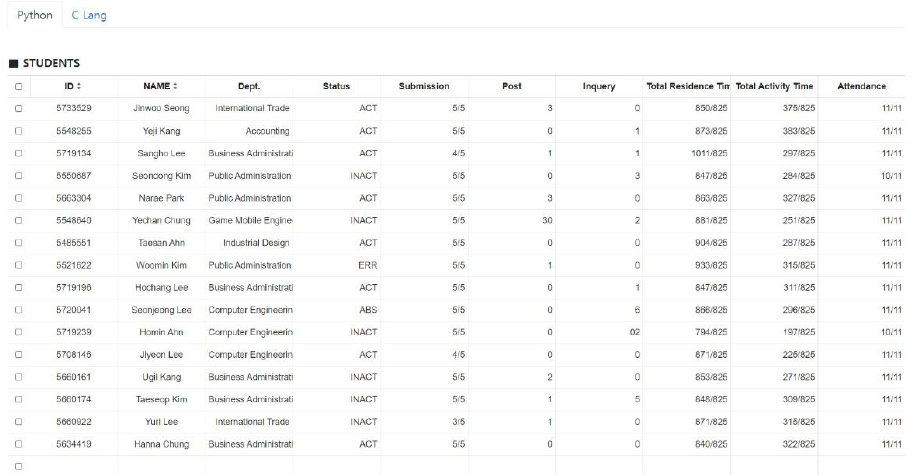
Figure 3. Results of analyzing student learning status.